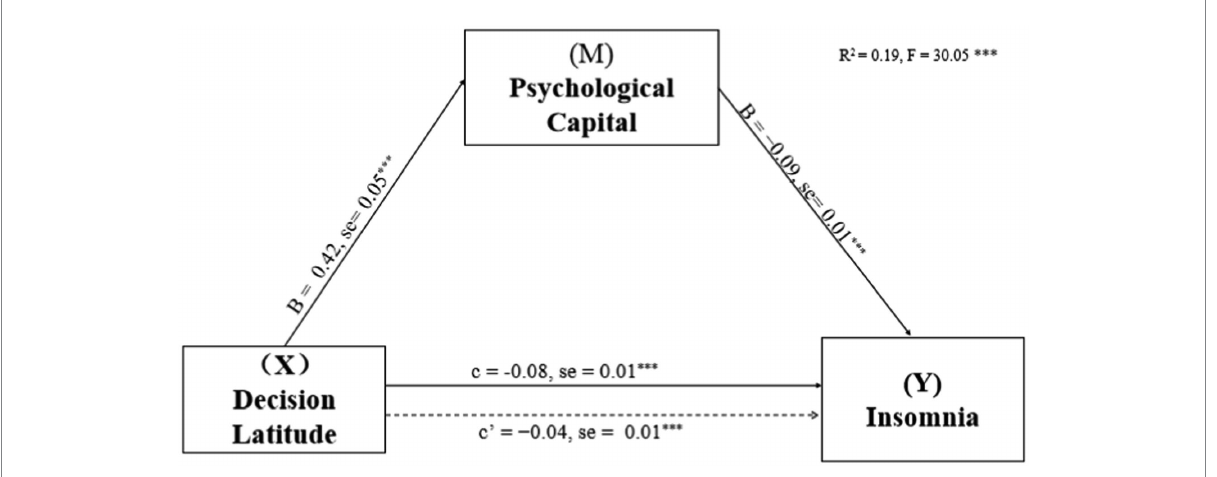
FIGURE 1 Mediation of Psychological capital in the relationship between decision latitude and insomnia symptoms with non-standardized beta values and standard error. *** p < 0.001.